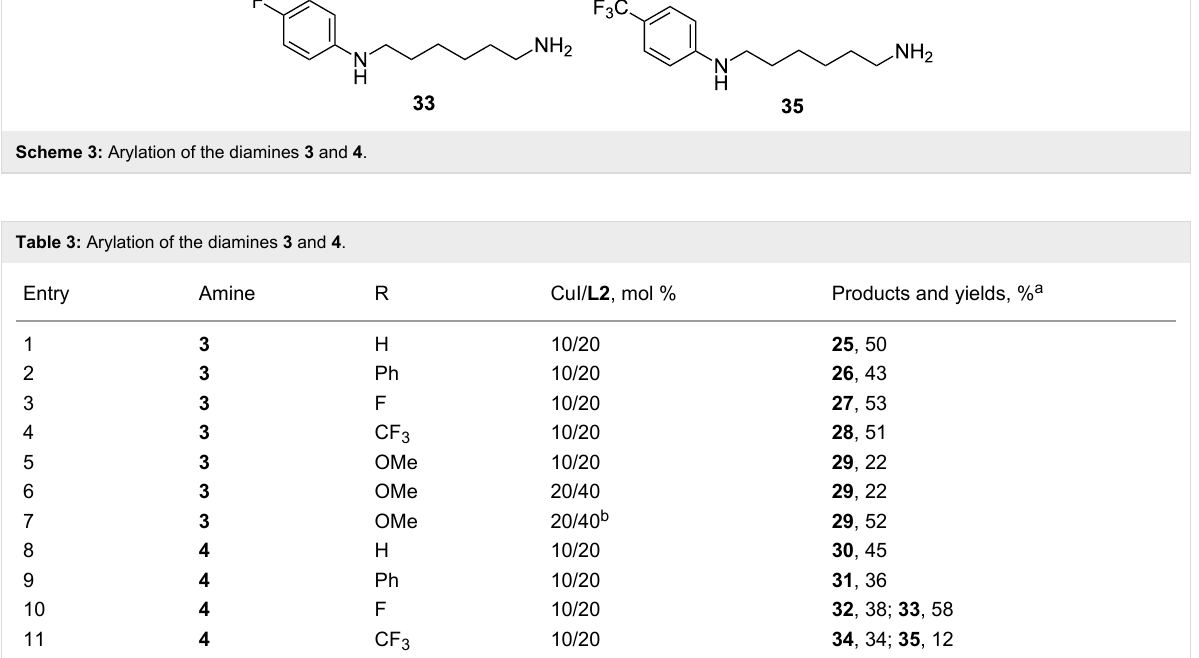
Scheme 3: Arylation of the diamines 3 and 4 .